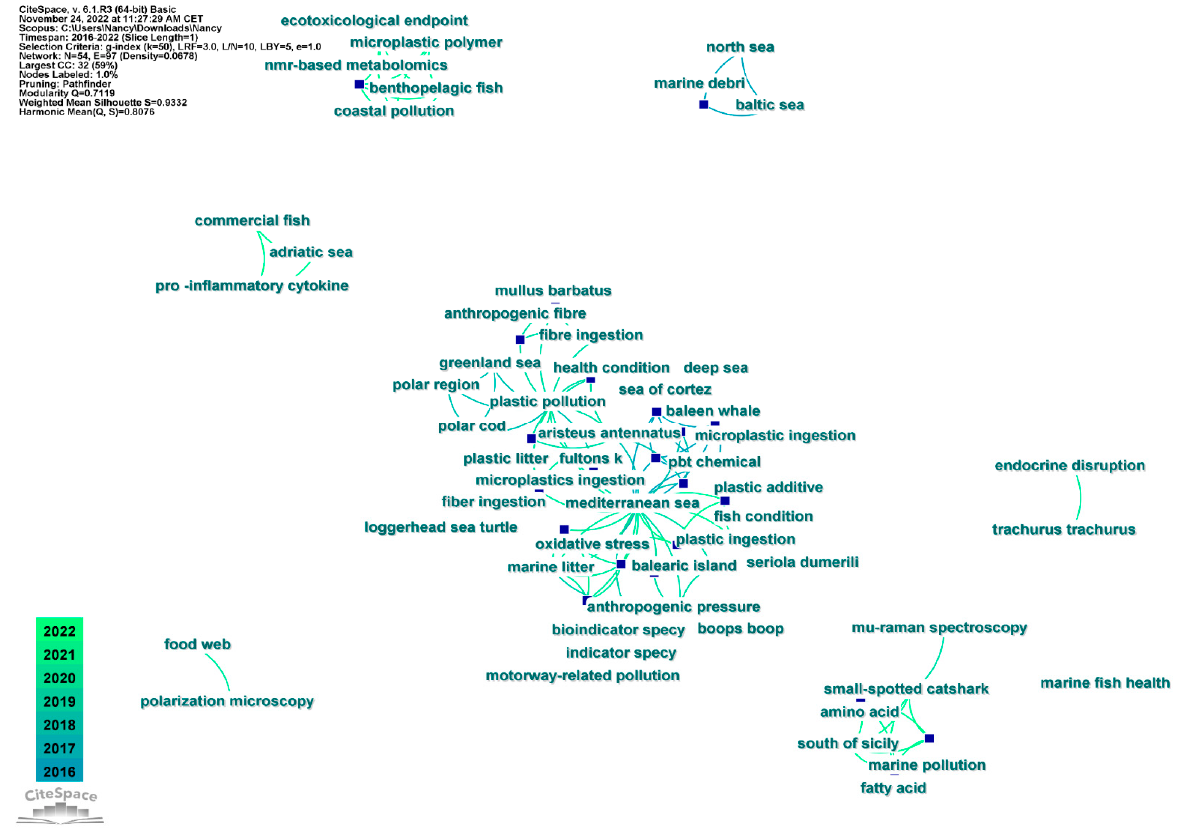
Figure 4. Keywords network, in which each node represents a keyword.